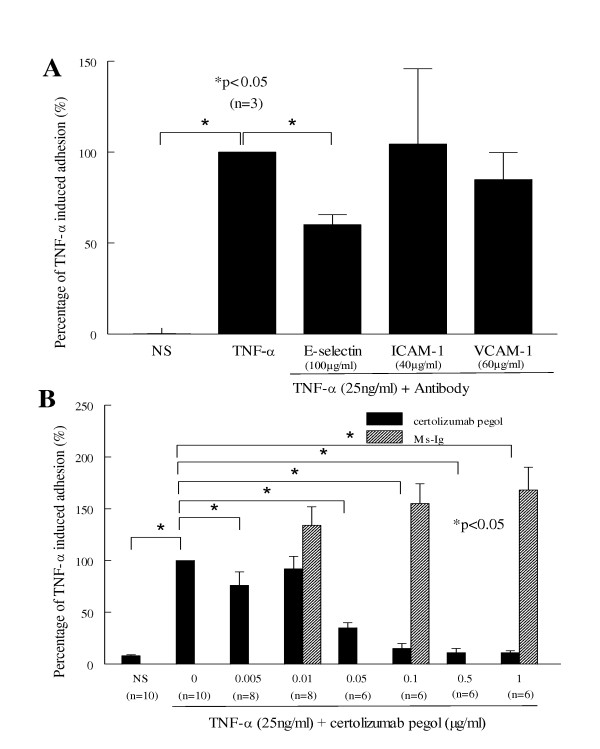
Certolizumab pegol inhibits HL-60 cell-human dermal microvascular endothelial cell adhesion induced by TNFα. TNFα-stimulated adhesion-molecule-mediated human promyelocytic leukemia (HL-60) cell-human dermal microvascular endothelial cell (HMVEC) adhesion is blocked by certolizumab pegol. Adhesion assays were performed using HL-60 cells and TNFα-preincubated HMVECs in the presence of anti-E-selectin or anti-intercellular adhesion molecule-1 (anti-ICAM-1) or anti-vascular cell adhesion molecule-1 (anti-VCAM-1) antibody, or of different concentrations of certolizumab pegol or mouse-IgG (Ms-Ig) control for 8 hours. (A) TNFα (25 ng/ml) significantly induces HL-60 adhesion to HMVECs, and anti-E-selectin but not anti-ICAM-1 or anti-VCAM-1 antibody block this interaction (*P < 0.05). (B) HL-60 cell adhesion to HMVECs is significantly inhibited by certolizumab pegol (0.005 to 1 μg/ml, from 10 to 57% of TNFα-induced binding; *P < 0.05). Results are presented as the percentage of TNFα-induced adhesion ± standard error of the mean. n, number of individual experiments. NS, nonstimulated.